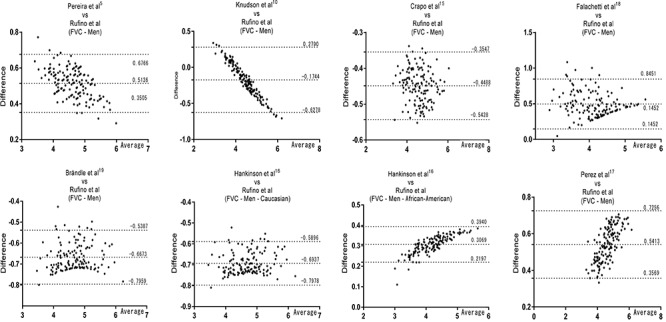
Results of the Bland-Altman test in the forced vital capacity (FVC) in men. Rufino et al. is the present study.